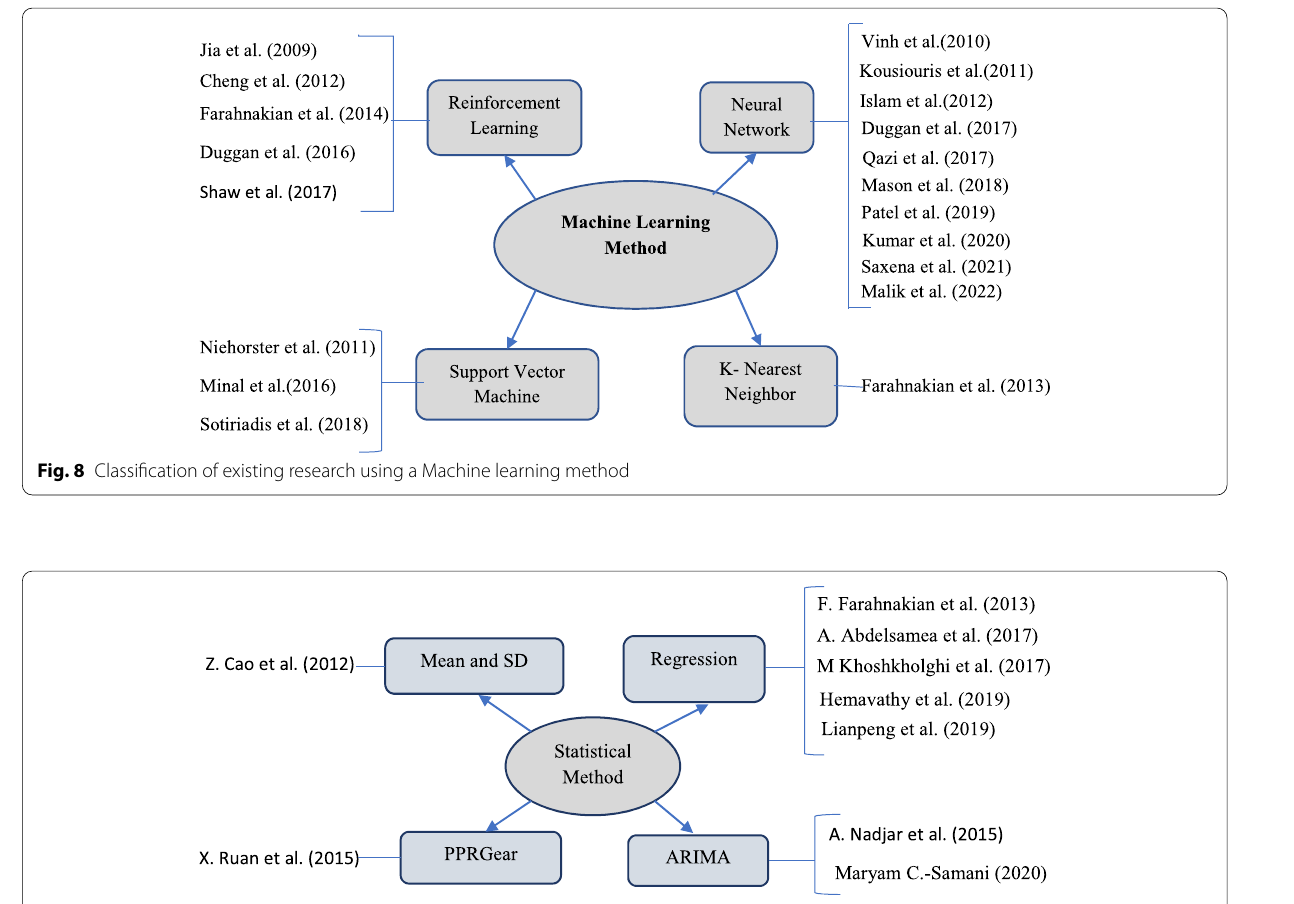
Fig. 9 Classification of existing research using Statistical